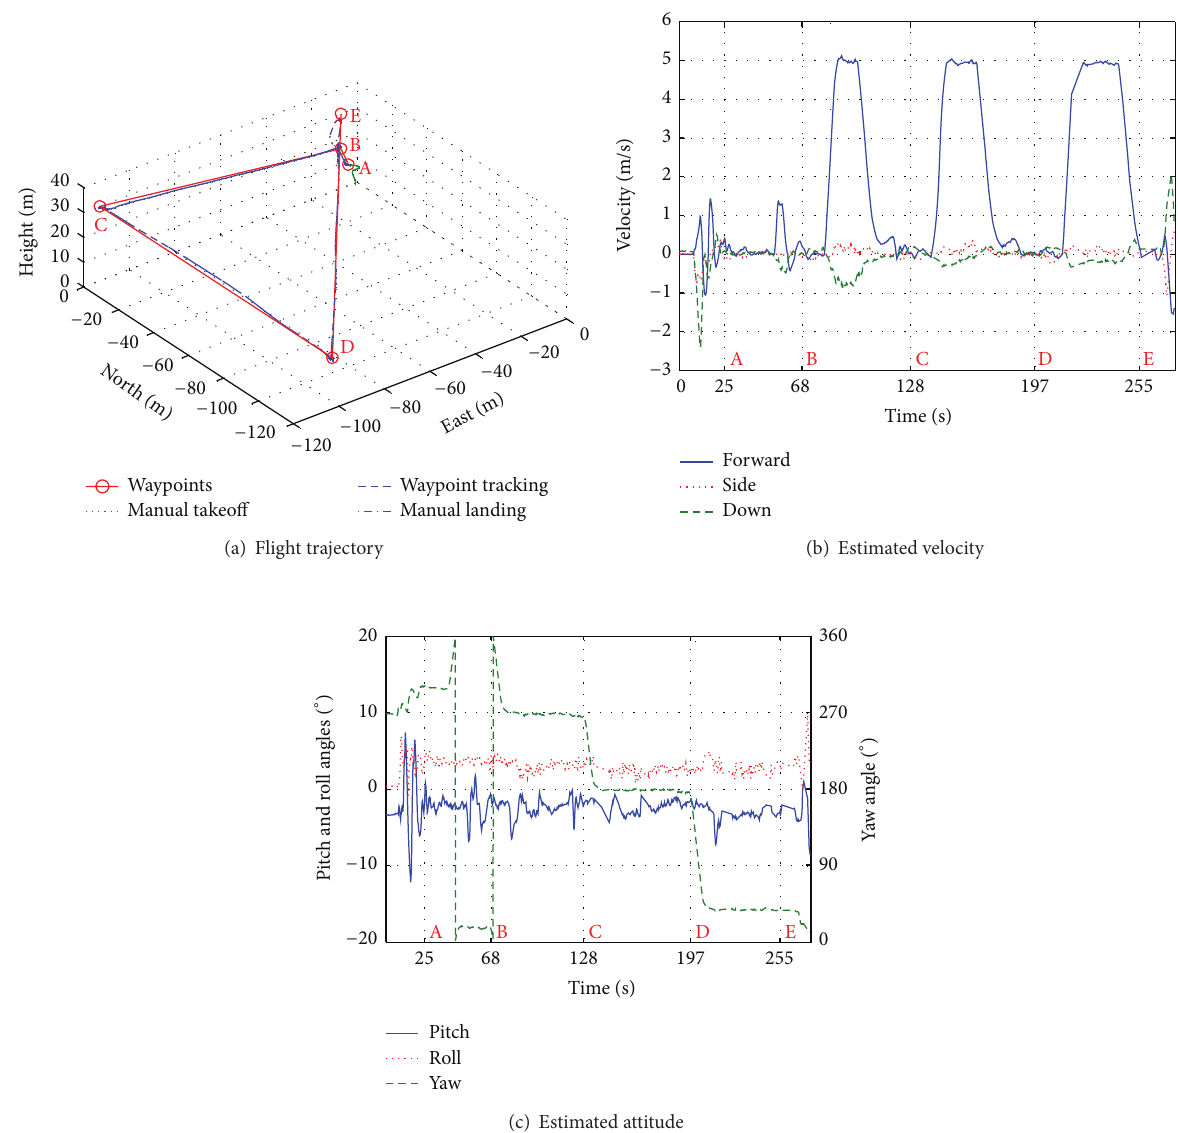
Figure 14: Estimated flight states of miniature unmanned helicopter in waypoint